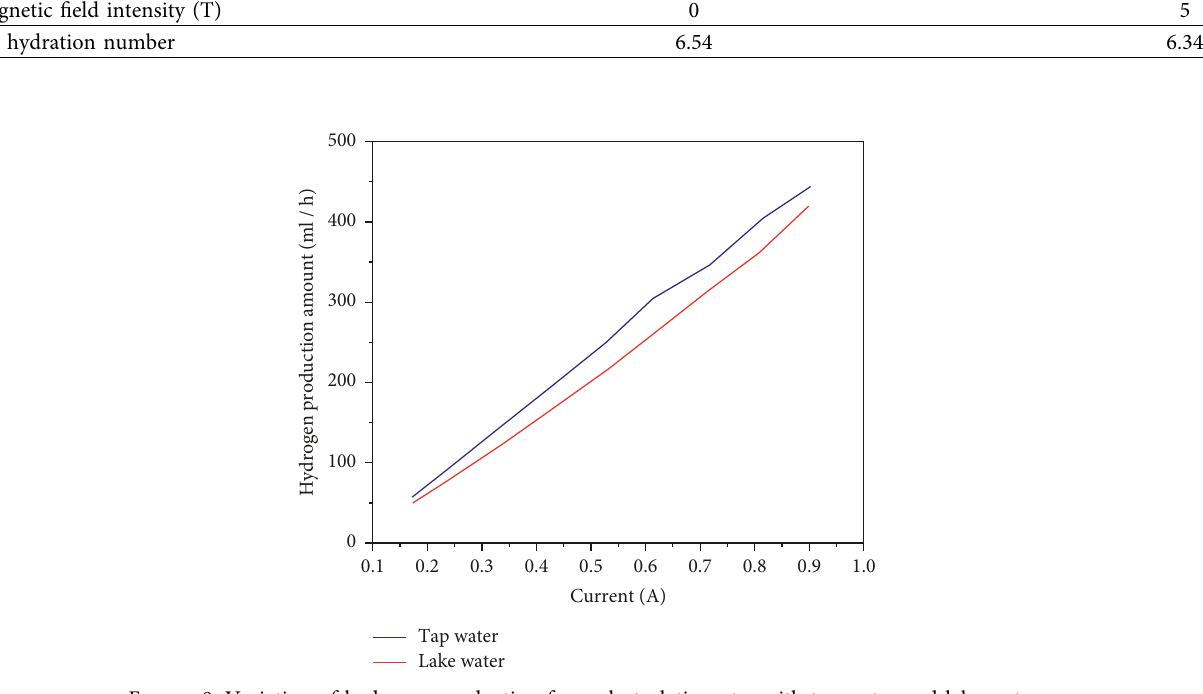
Figure 8: Variation of hydrogen production from electrolytic water with tap water and lake